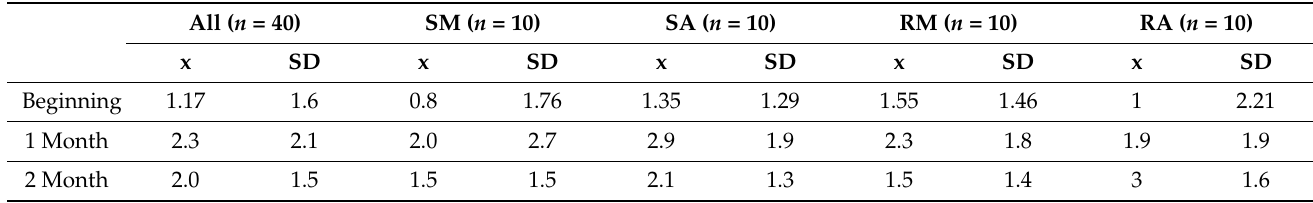
Table 8. Height of peri-implant